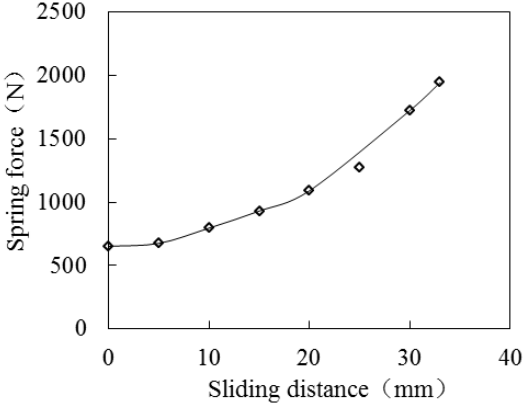
Figure 22. Relationship between spring force and PMs sliding